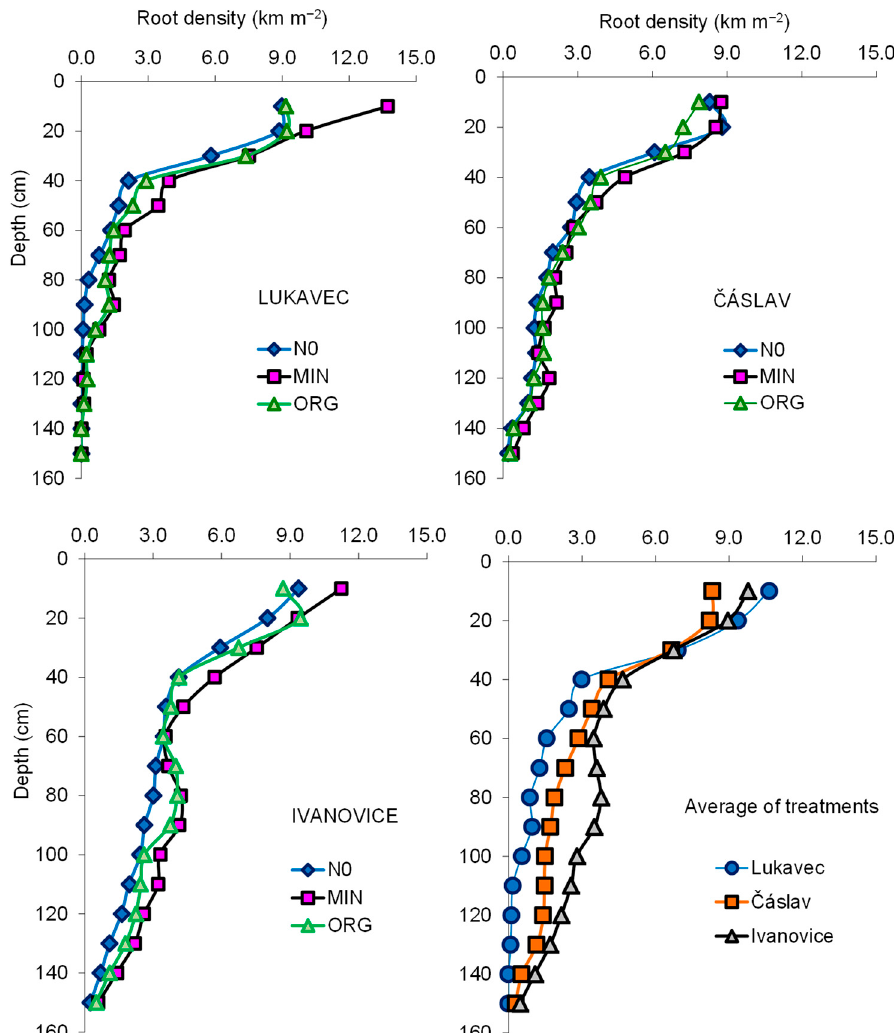
Figure 3. Average distribution of root density in the soil profile of the N0, MIN, and ORG treatments at the Lukavec, Č áslav, and Ivanovice sites. The average of the N0, MIN, and ORG treatments at the experimental sites is shown in the bottom right. N0 − zero fertilization, MIN − mineral fertilization, ORG − organic fertilization.